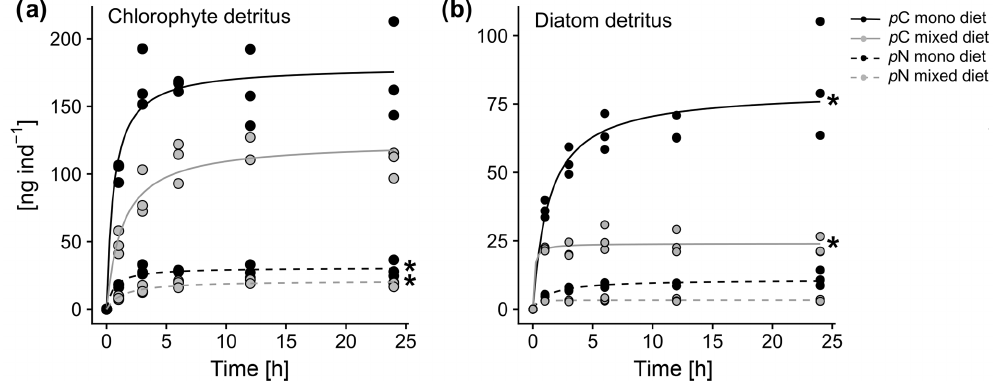
Figure 4. Comparison of chlorophyte and diatom phytodetritus feeding in A. tepida for 24h, presenting feeding dynamics for (a) chlorophyte detritus and (b) diatom detritus. Curves show Michaelis–Menten fits through triplicates for each approach (stars indicate calculated values for pC or pN). Table 2. Michaelis–Menten parameters of curves for pC and pN intake in Fig. 4 (bold font shows data from measured values, and regular font shows data from calculated values; V max is the maximum pC/pN, Km is the half saturation for pC/pN, Res. SE is the residual standard error, and DF is the degrees of freedom). V max Km Res. SE DF pC Chlorophyte mono